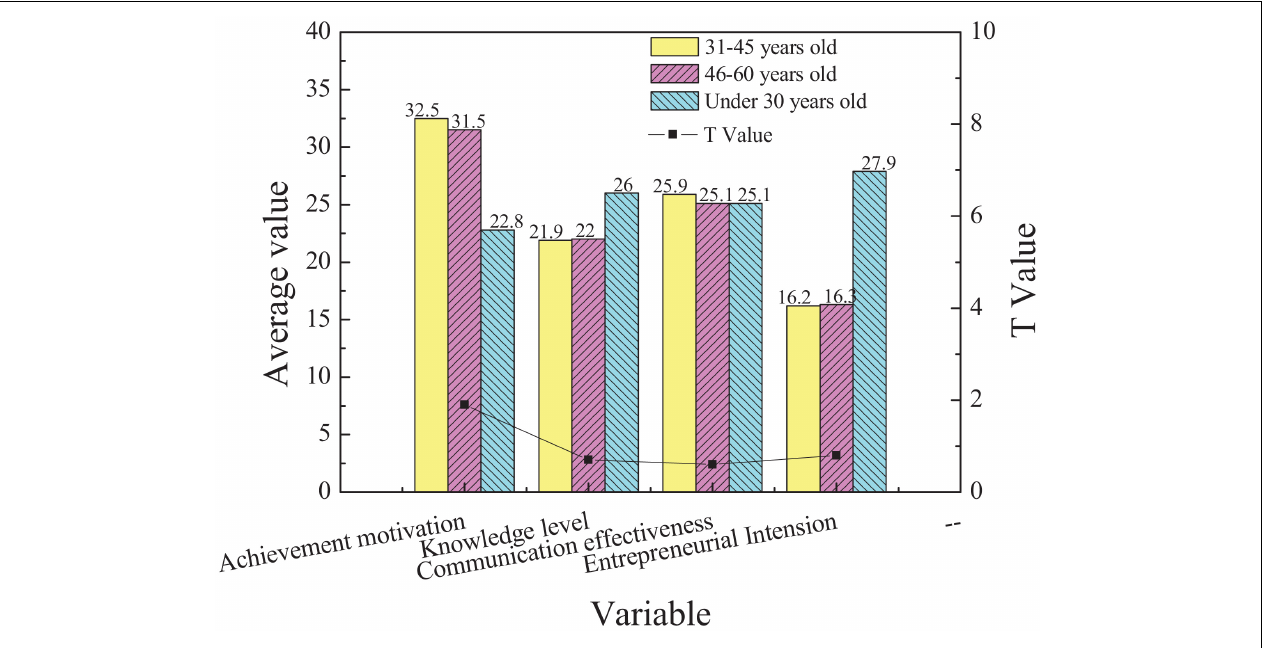
FIGURE 5 | Comparison of scores of new entrepreneurs of different ages in different EI